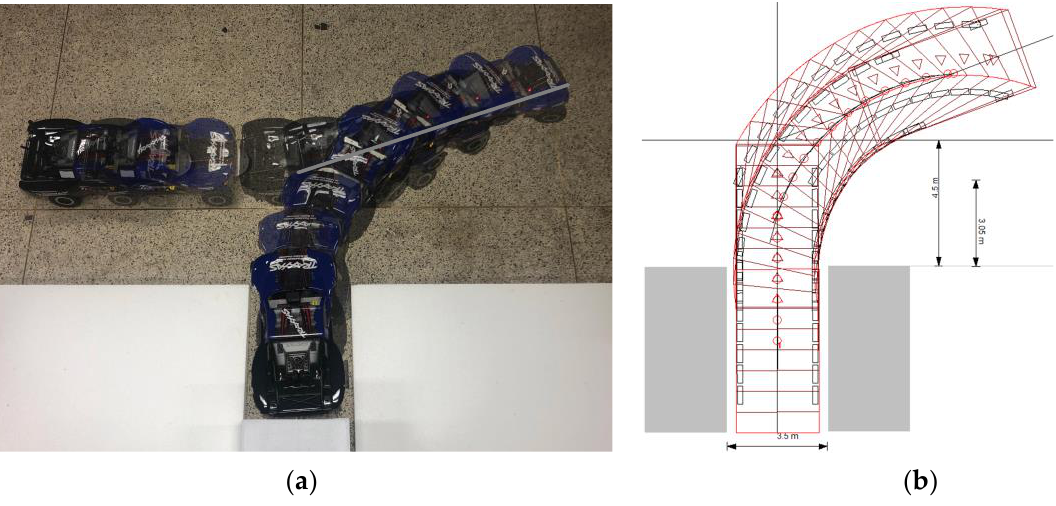
Figure 13. Five-characters ( 𝑆 + 𝐿 + 𝑆 + 𝑅 − 𝑆 − ) perpendicular parking in a narrow spot: ( a ) Experimental parking test; ( b ) simulated parking path.